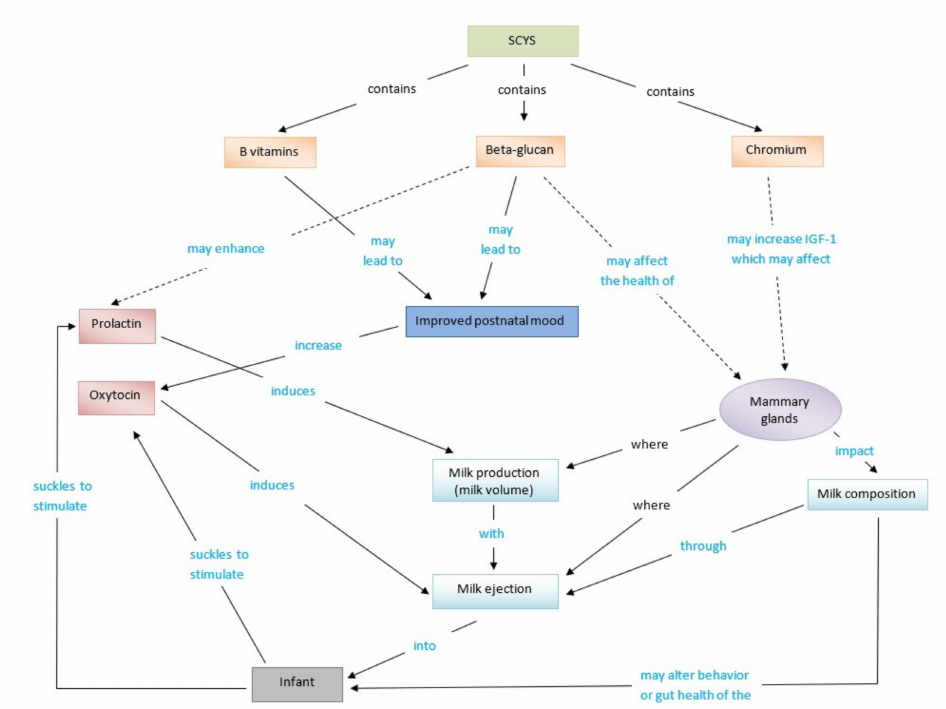
Figure 1. The potential mechanism of Saccharomyces cerevisiae yeast-based supplements (SCYSs) on breast milk production and composition. The dashed arrow means there is a lack of evidence in humans to support the proposed